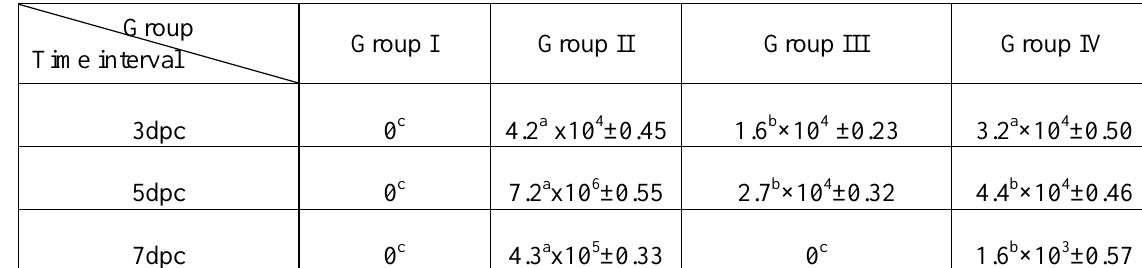
Table 6: Efficacy of ECV extract on viral shedding at the three-time interval after NDV challenge by using